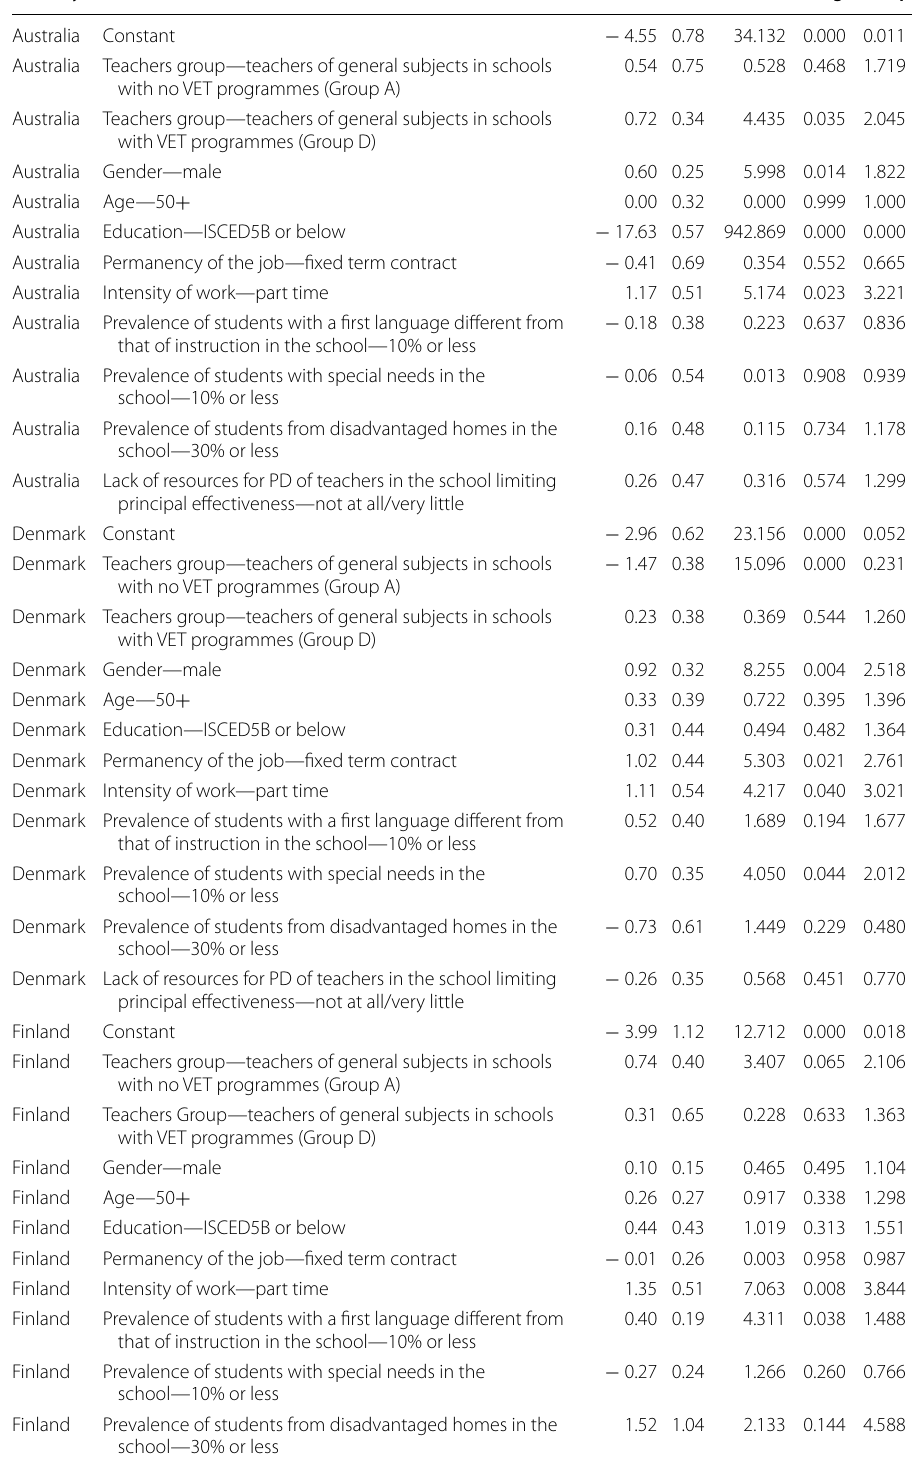
Table 13 Non participation in teachers’ professional development: results of the logistic regression models, regressors R1–R10, all countries including Italy, 2013 (Source: Author’s calculations based on OECD, TALIS